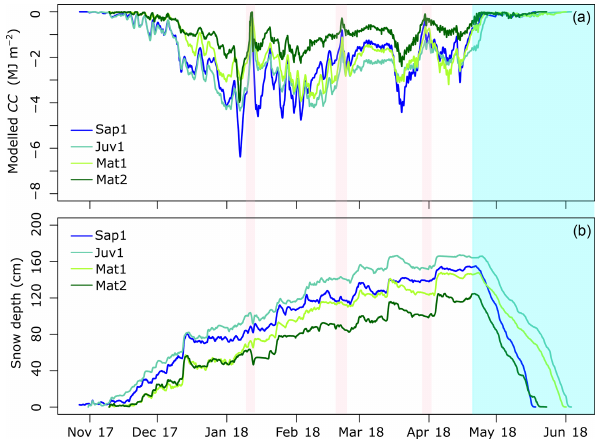
Figure 10. (a) Total estimated CC from the reconstructed time se- ries. An exponential moving average was applied for noise removal. (b) Snow depth observations. Spring melt period and rain-on-snow events are highlighted with light blue and light pink colours, respec- tively.